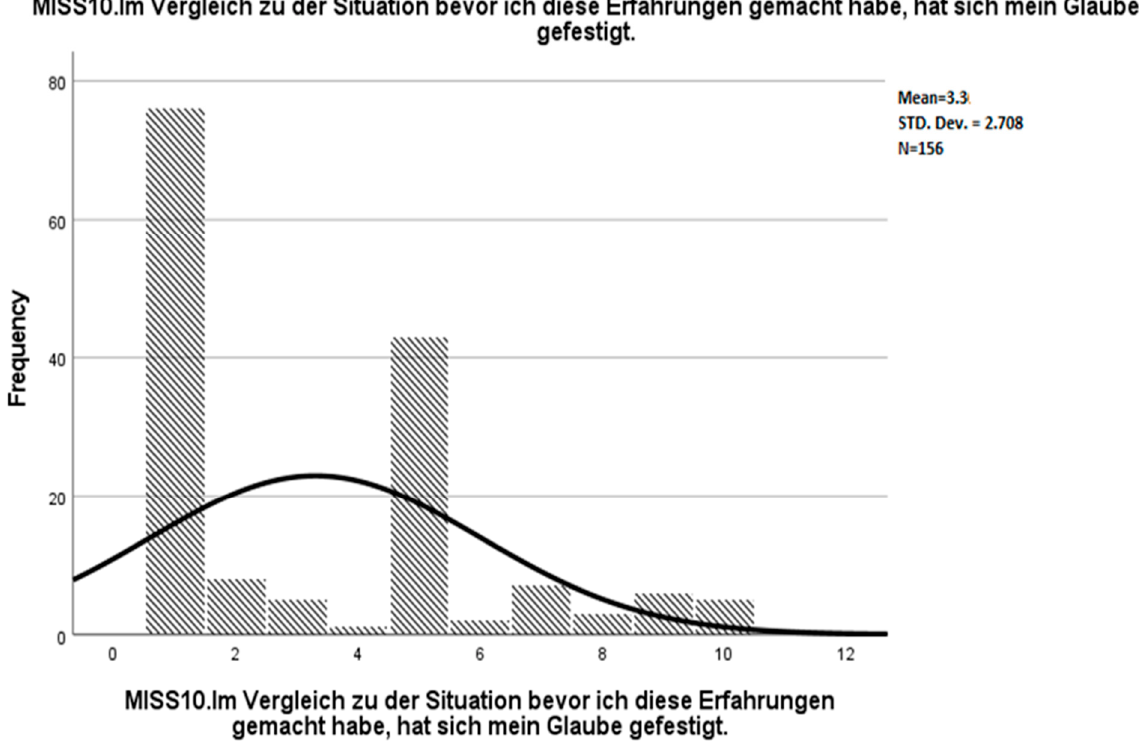
Figure 7. Frequency distribution of MISS10 in the present study, German version.